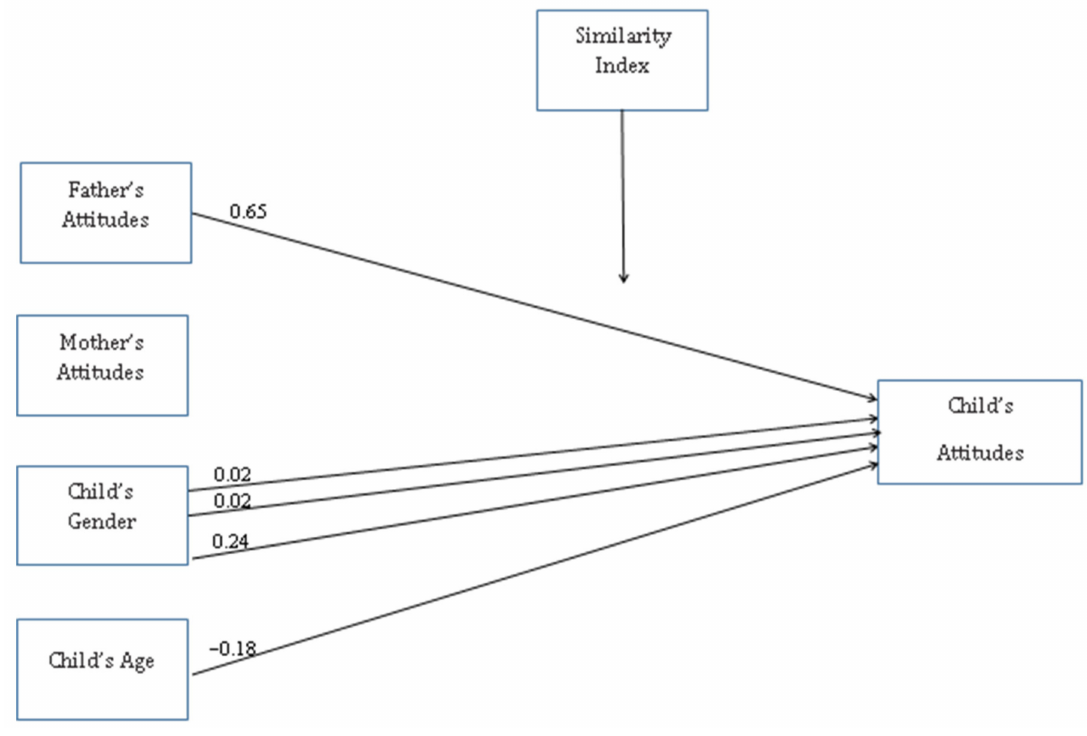
Figure 2. Attitudes toward children with SD.